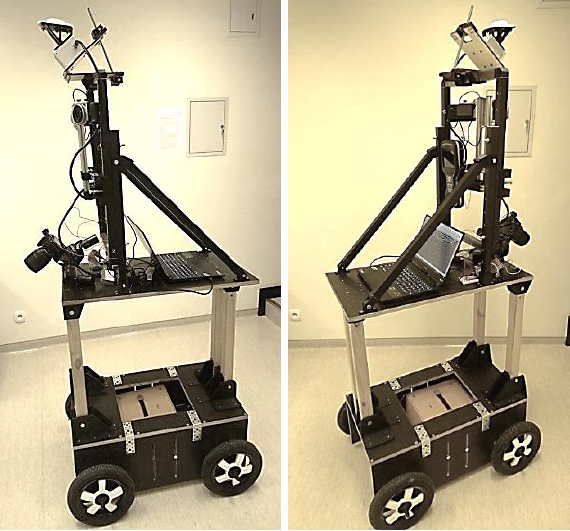
Figure 1. The prototype of the platform with integrated sensor s